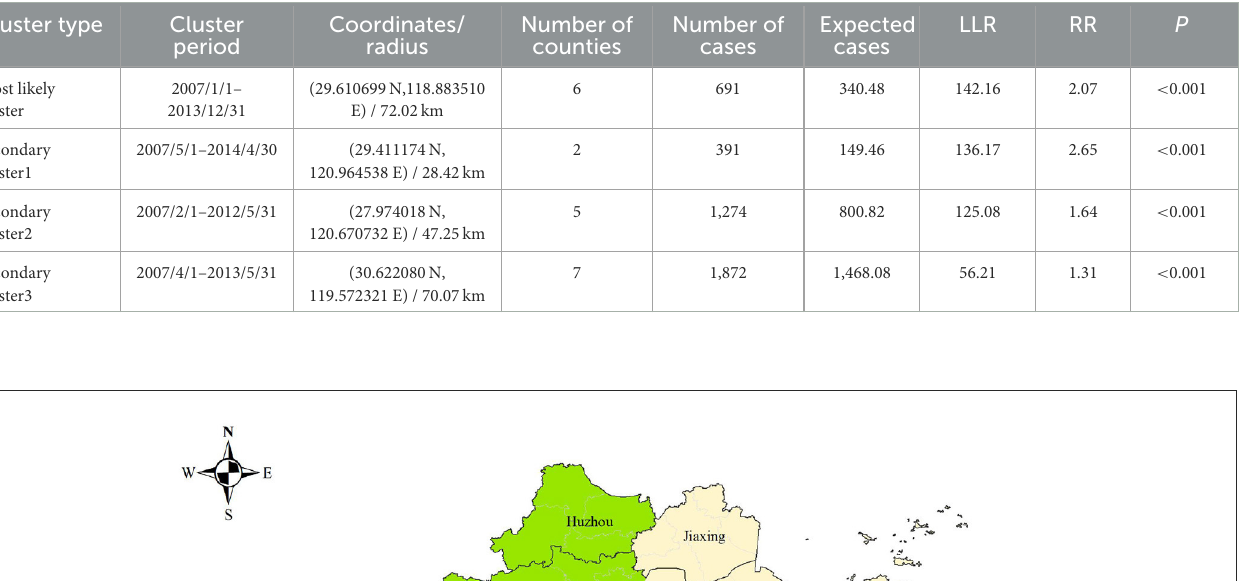
TABLE 4 Results of spatial-temporal scanning of PTB among students in Zhejiang, 2007–2020.